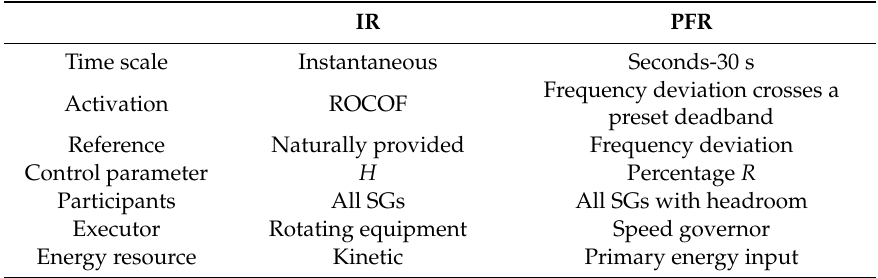
Table 1. Properties of inertia response (IR) and primary frequency responses (PFR). ROCOF: change of the range of frequency, SGs: synchronous generators. IR